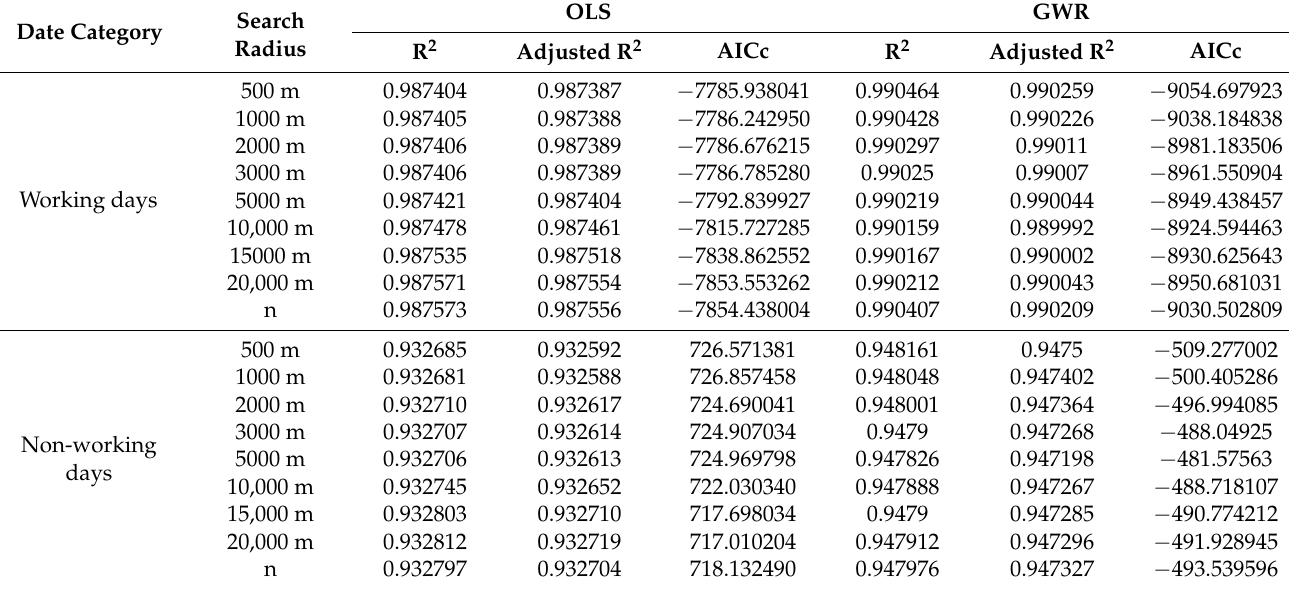
Table 6. Diagnostic information of OLS and GWR